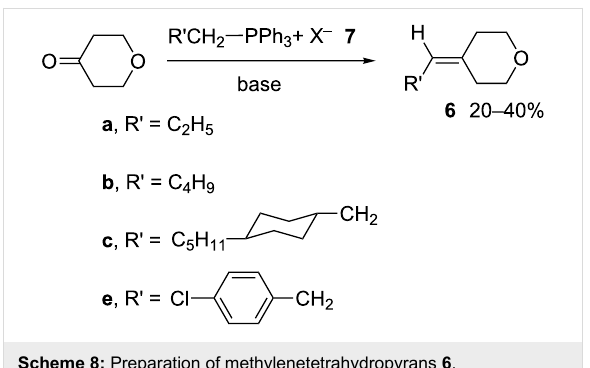
Scheme 8: Preparation of methylenetetrahydropyrans 6